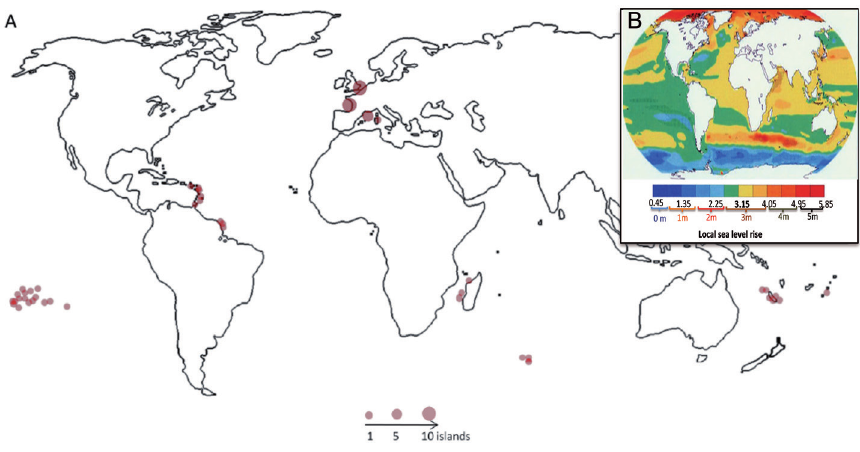
Figure 2. A Spatial distribution of submerged French islands following the pessimistic scenario (~3 m rise) B Local sea level change (m) due to ocean density and circulation change relative to the global average during the 21 st century under SRES A1B